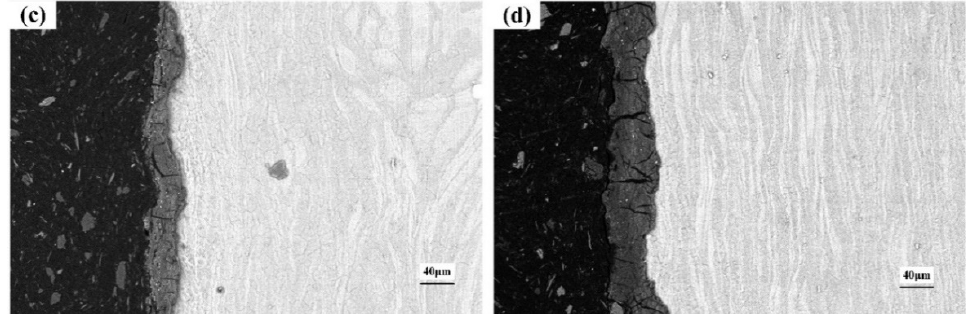
Figure 14. Cross-section morphology after corrosion in 1.0 mol/L Cl − solution: ( a ) 4 h; ( b ) 8 h; ( c ) 18 h; ( d ) 36 h.